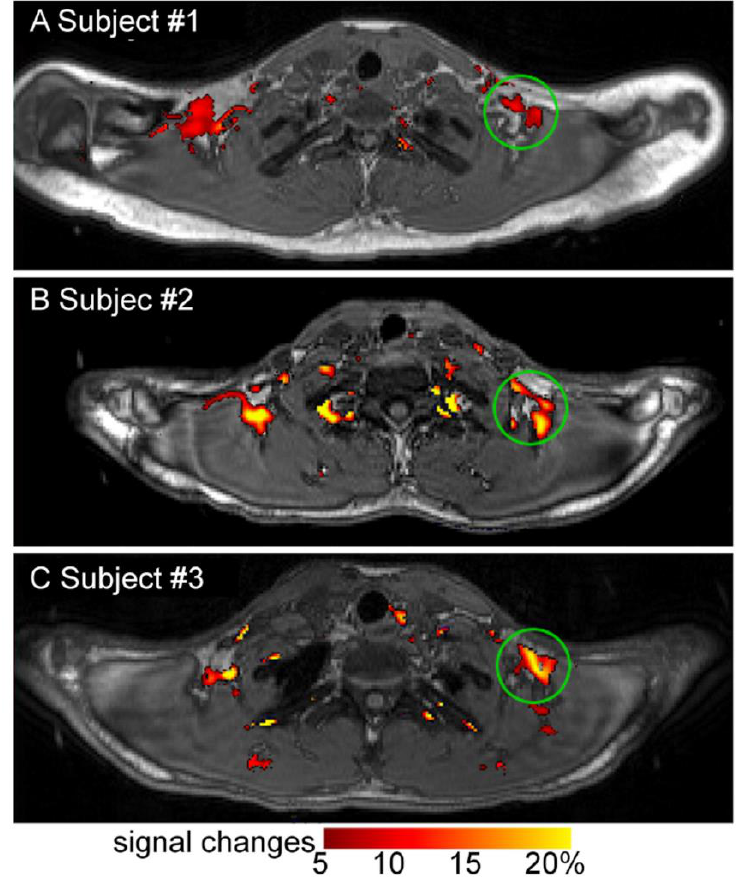
Figure 4. Change in blood oxygen level dependent MRI signal in human BAT with cold exposure. Change in blood oxygen level dependent MRI signal in supraclavicular BAT with cold exposure (13–16 °C) in healthy human research subjects. Images A , B , and C are representative images of 3 subjects. Image reproduced with permission from reference 47.